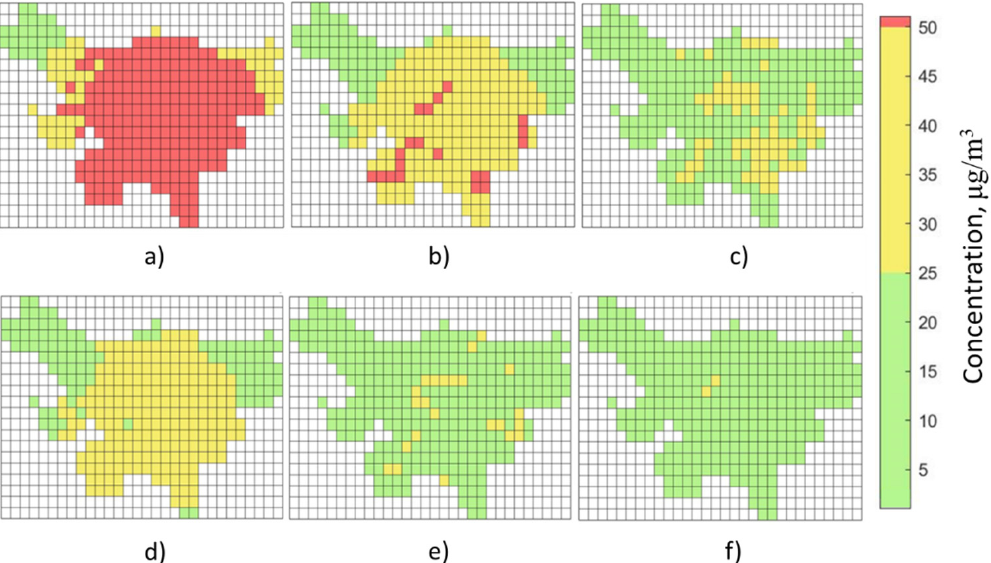
Figure 15. PM10 monthly average measured by the ROM network in Milan: ( a ) January 2020; ( b ) February 2020; ( c ) March